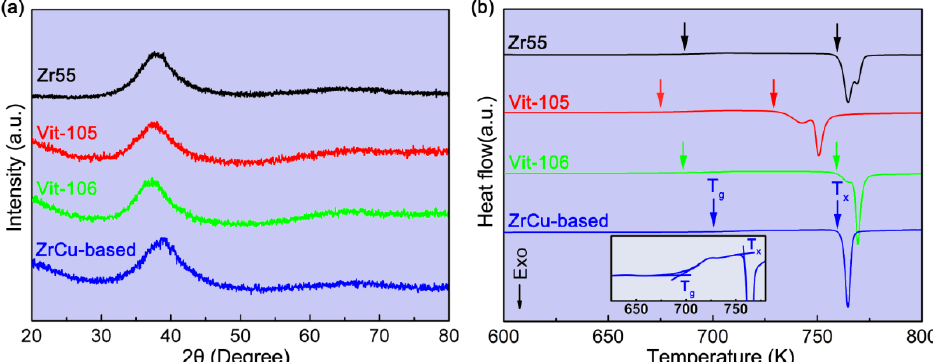
Figure 2. ( a ) XRD patterns of the Zr 55 Cu 30 Ni 5 Al 10 (Zr55), Zr 52.5 Ti 5 Cu 17.9 Ni 14.6 Al 10 (Vit105), Zr 57 Nb 5 Cu 15.4 Ni 12.6 Al 10 (Vit106), and Zr 46.5 Cu 47.5 Al 4 Co 1 Sn 1 (ZrCu-based) samples with different thicknesses; ( b ) DSC curves for the different BMGs fabricated using EPV-HPDC, the glass transition temperature ( T g ) and the crystallization temperature ( T x ) are arrowed. The inset in ( b ) displays the details of the glass transition behavior of the ZrCu-based BMG.